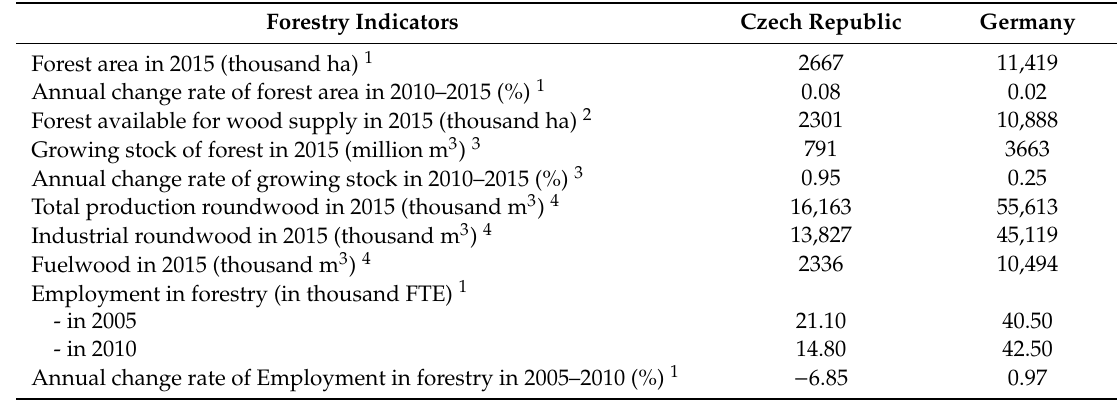
Table 1. Selected forestry indicators in the Czech Republic and Germany after the introduction of the studied forest